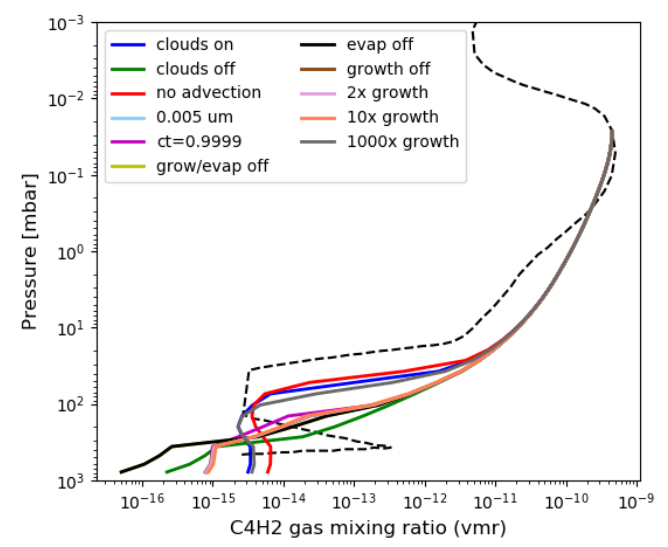
Figure 6. Sensitivity tests showing the effects of different microphysical processes on the C 4 H 2 gas in Saturn’s atmosphere after the 2010 storm. The dashed curve shows the C 4 H 2 volume mixing ratio modeled by [23] for the aftermath of the storm in May 2011. C 4 H 2 gas is created each timestep using a gaussian production function to simulate photochemistry. Loss occurs through cloud formation. The spike in C 4 H 2 below 100 mbar is believed to be due to evaporation of C 4 H 2 ice particles. This is consistent with microphysics modeling which shows the absence of any spike when the evaporation process is turned off (green—no cloud microphysics, black—no evaporation, yellow—no growth or evaporation). Other tests show how altering cloud parameters affects the amount of evaporated C 4 H 2 such as changing the minimum radius of cloud particles from 0.1 µ m to 0.005 µ m, increasing the contact parameter for heterogeneous nucleation from 0.9991 to 0.9999 to make nucleation more efficient, and increasing the condensation rate. The modular structure of PlanetCARMA allows these parameters to be changed with minimal to no changes within the